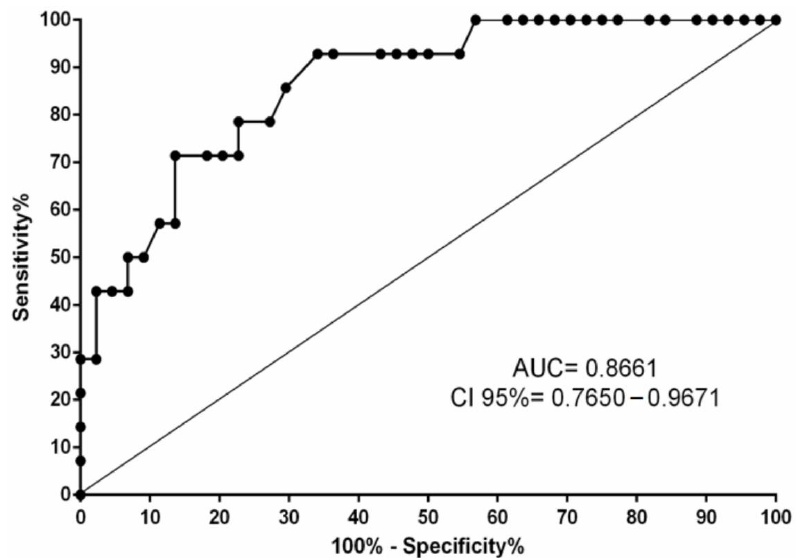
Figure 3. ROC curve for IFN- γ levels for the diagnostic prediction of extrapulmonary tuberculosis.